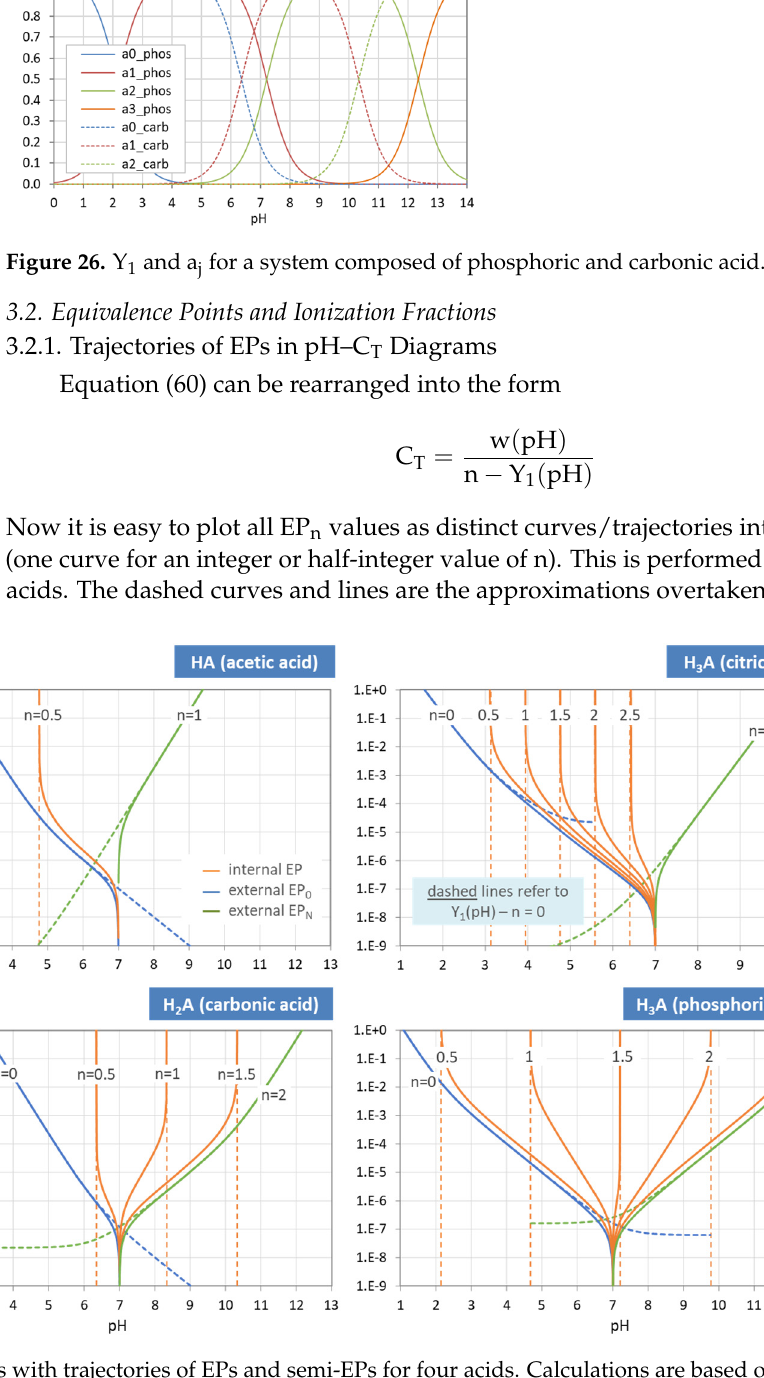
Figure 27. pH–C T diagrams with trajectories of EPs and semi-EPs for four acids. Calculations are based on Equation (117).